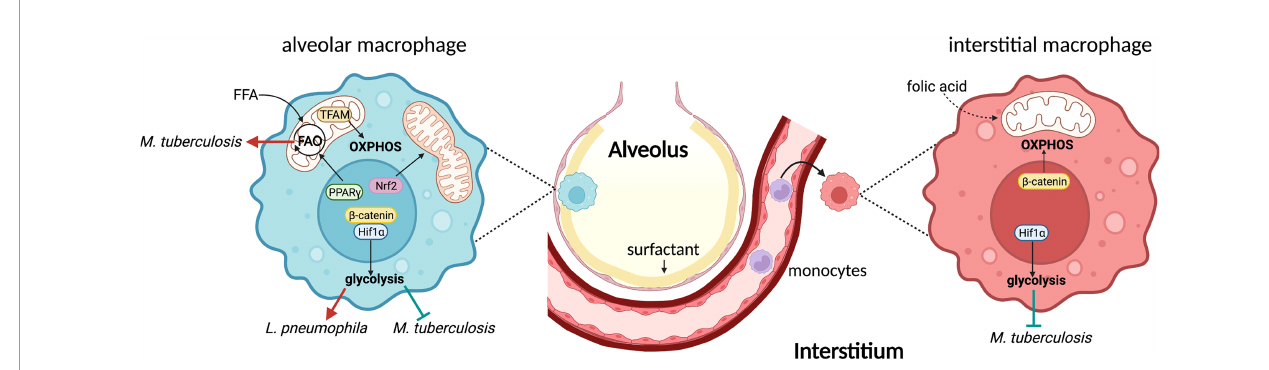
FIGURE 1 | Lung macrophages exhibit distinguished metabolic pathways during bacterial infections. AMs reside in the alveolar space and express high level of PPAR g to promote FFA uptake and FAO. Nrf2 activation leads to mitochondrial fusion which in turn promotes OXPHOS in AMs. Additionally, TRAM-mediated mitochondrial metabolism is essential for AM maintenance and function. Hif1 a is the key transcription factor to promote glycolysis in AMs. b -catenin is required for this process, at least during viral infection. AMs represent a permissive cellular niche for Mtb, likely because of the high FAO. Glycolysis inhibits intracellular Mtb growth, whereas it promotes L. pneumophila replication. On the other hand, IMs originate from monocytes and control Mtb infection, largely due to the high glycolytic activity mediated by Hif1 a . b -catenin, however, promotes mitochondrial respiration in IMs. One subset of IMs expresses folate receptor, an indication of their capability to utilizing folic acid. FFA, free fatty acids; FAO, fatty acid